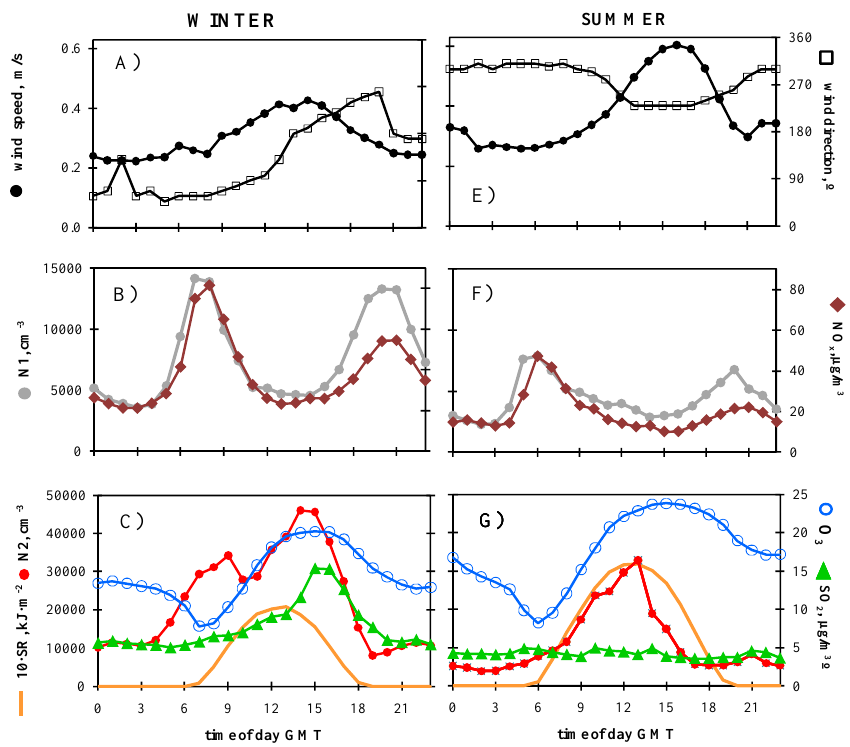
Fig. 8. Hourly average values of N1, N2, NO x , SO 2 and O 3 concentrations, of wind speed and direction and of solar radiation (SR) in Huelva in winter and summer.